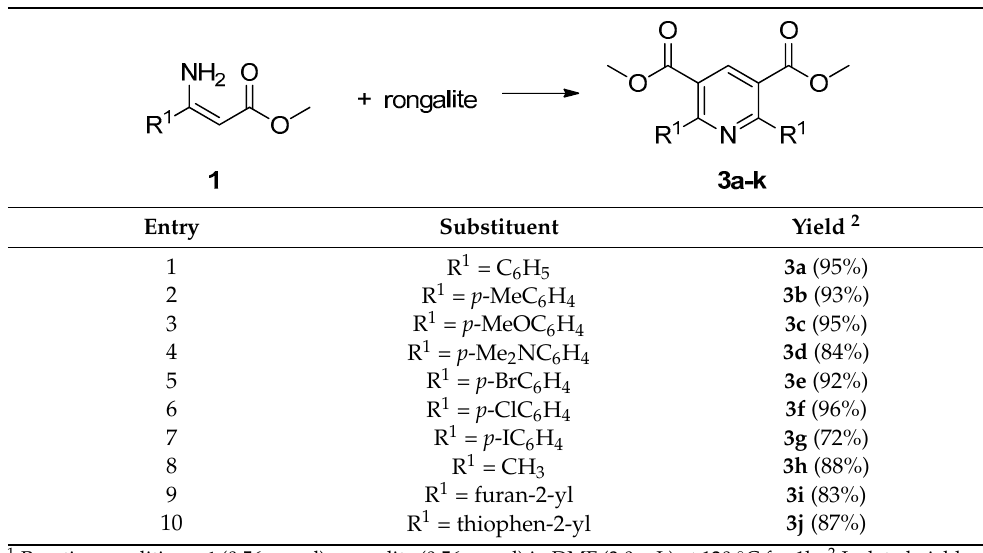
Table 2. Reaction scope 1 .